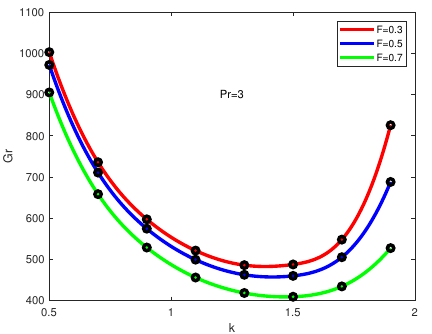
Figure 7. Marginal stability curves for Pr = 3 (Case